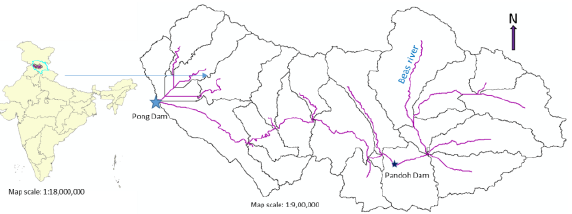
Figure 1: Study area, Beas basin up to Pong dam in Himachal Pradesh state of